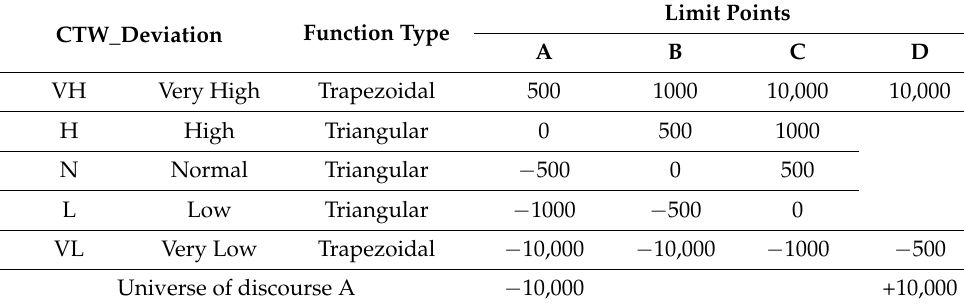
Figure 6. Graphical description of variable CTW_deviation ( σ w ). Table 3. Membership functions for variable CTW_deviation ( 𝝈 𝒘 ).